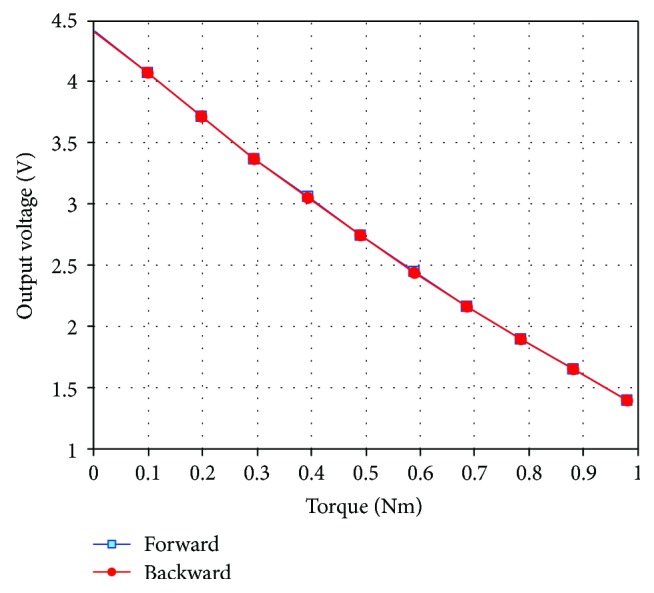
Hysteresis curve.